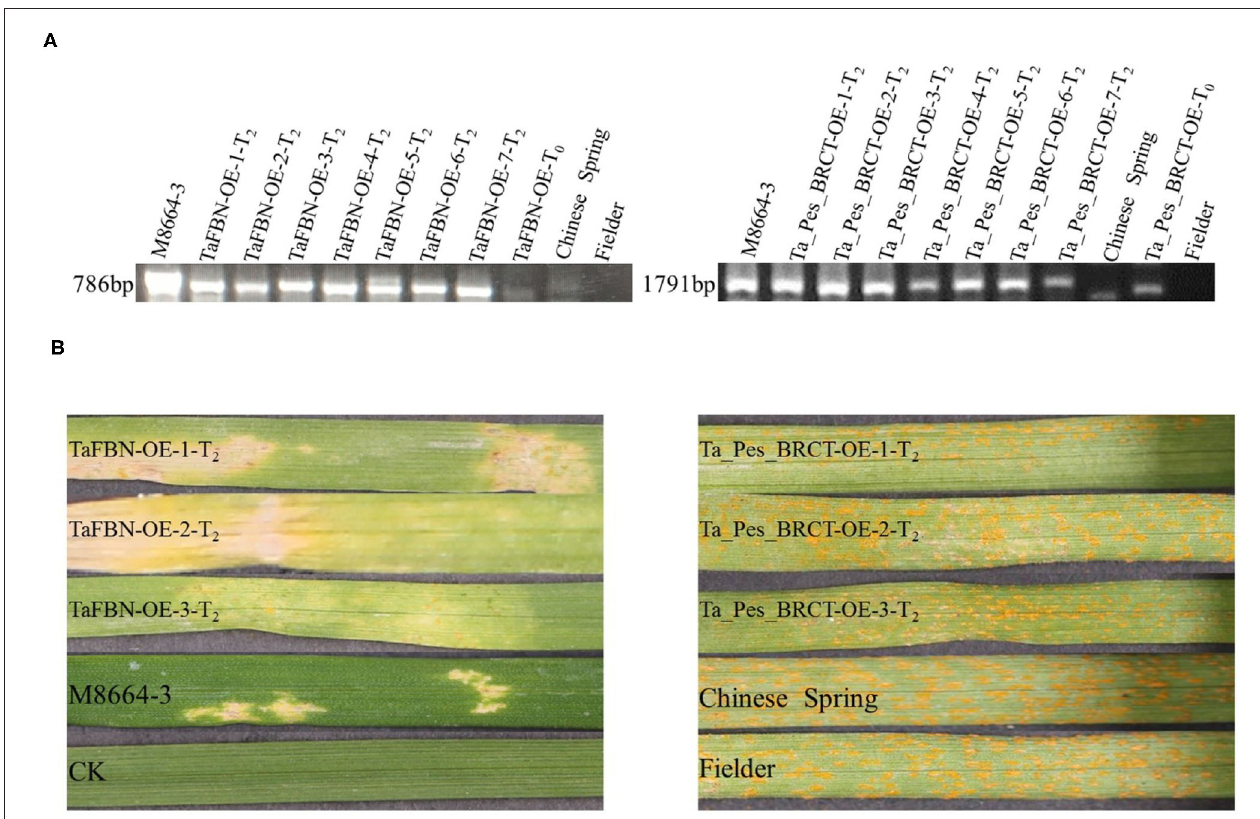
FIGURE 6 | Stable transformation of the susceptible bread wheat cultivar Fielder with TaFBN confers resistance to Pst race CYR33. (A) Identification by PCR of individuals transformed with TaFBN and Ta_Pes_BRCT . Wild-type Fielder was used as a negative control; M8664-3 containing the full sequence of TaFBN and Ta_Pes_BRCT was used as a positive control. (B) Fielder T 2 plants transformed with TaFBN were resistant to CYR33 but those transformed with Ta_Pes_BRCT were susceptible to CYR33. Wild-type Fielder, Chinese Spring, and M8664-3 were used as susceptible and resistant